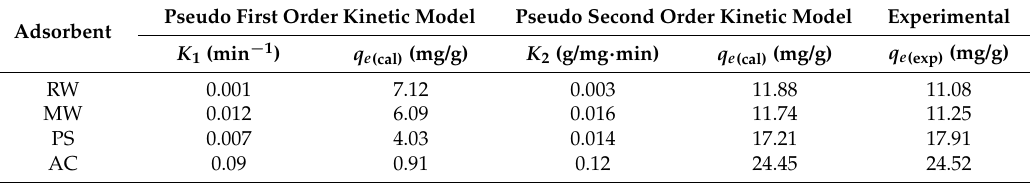
Table 1. Parameters for pseudo first-order and pseudo second-order models.